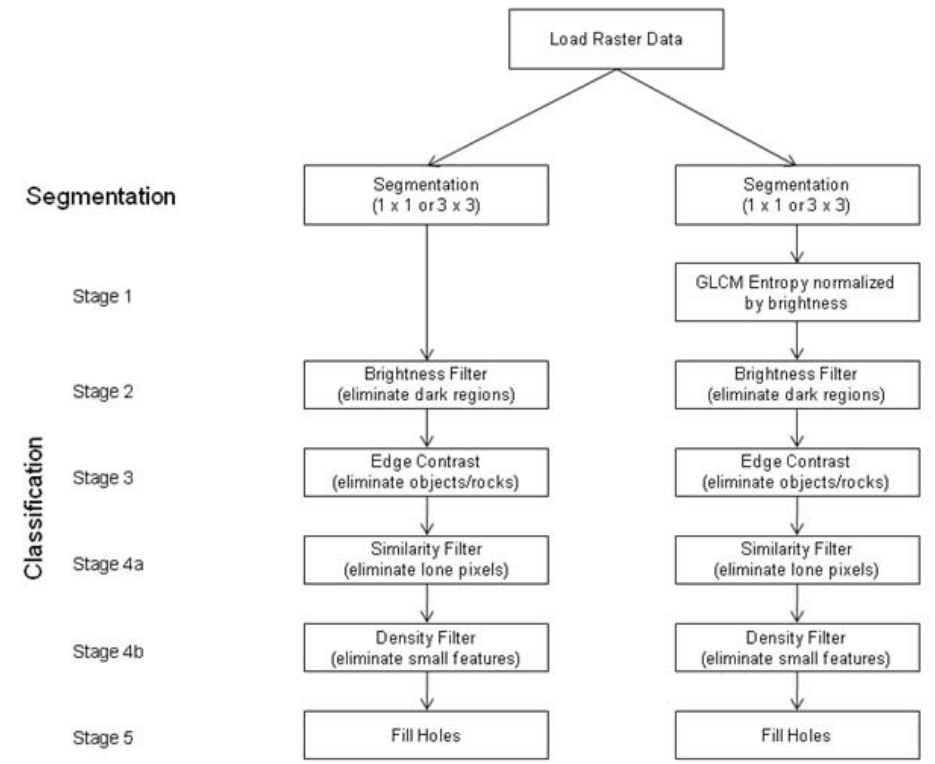
Fig. 4. eCognition workflow steps for the identification of avalanche signatures from VHR optical satellite imagery. Note the slight variation in methodology when using Leica ADS40-SH52 imagery (left workflow) versus QuickBird imagery (right